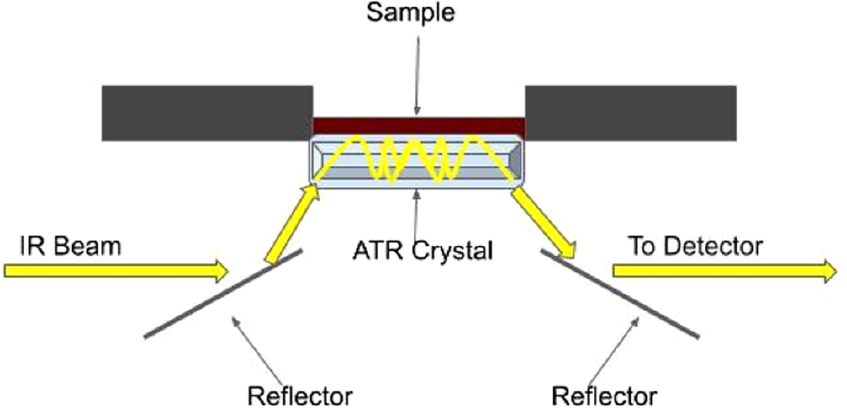
Figure 8. ATR spectroscopy illustration. When an infrared beam enters the ATR device, it is reflected by a series of reflectors and directed toward the ATR crystal that is in contact with target sample. The light is reflected by the crystal producing an evanescence. After leaving the ATR crystal, the reflected energy is directed toward a spectrometer, which generates a sample reflectance spectrum. [Reprinted from ref. [13], by Lamar Burton1, K. Jayachandran2 and S. Bhansali; via IOP (CC BY